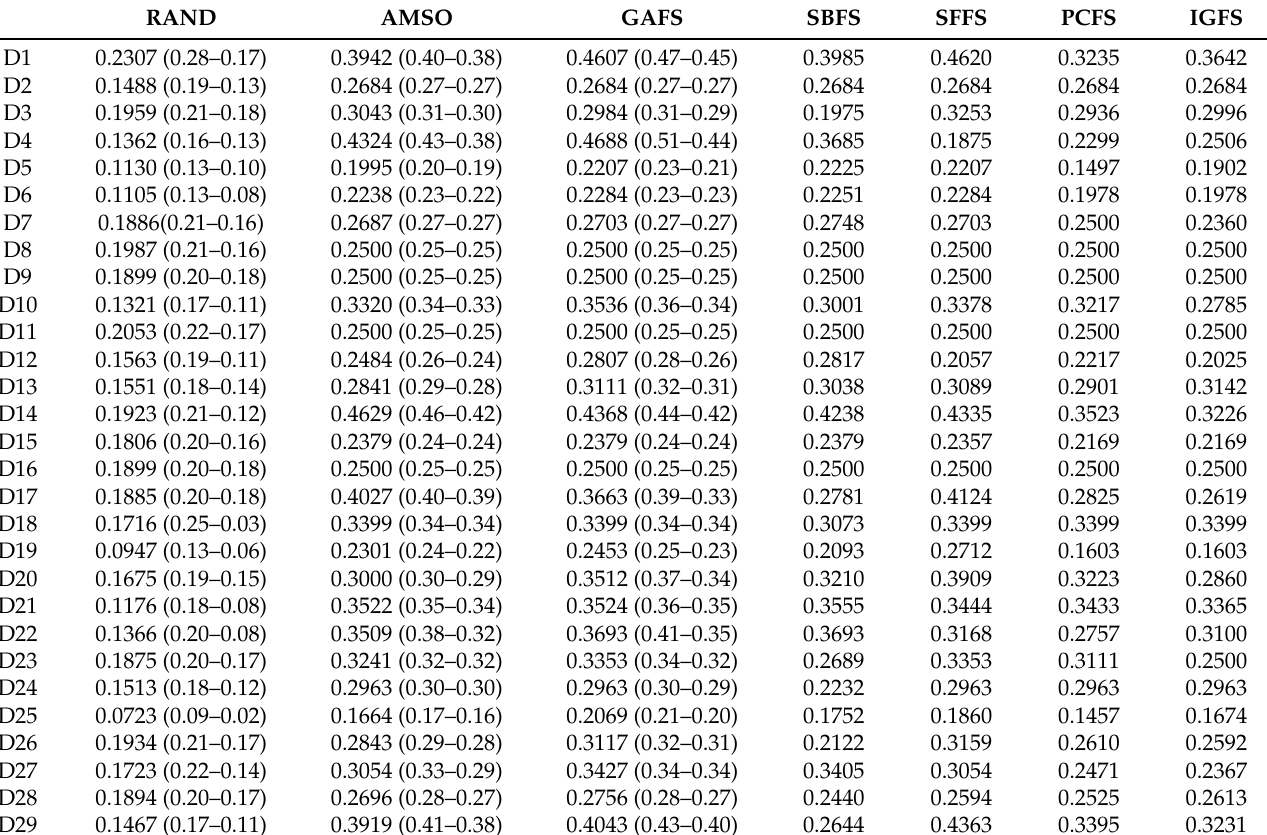
Table 8. BFI results reported as medians for the first three stochastic algorithms (with interquartile ranges in parentheses) and as single values for the remaining deterministic